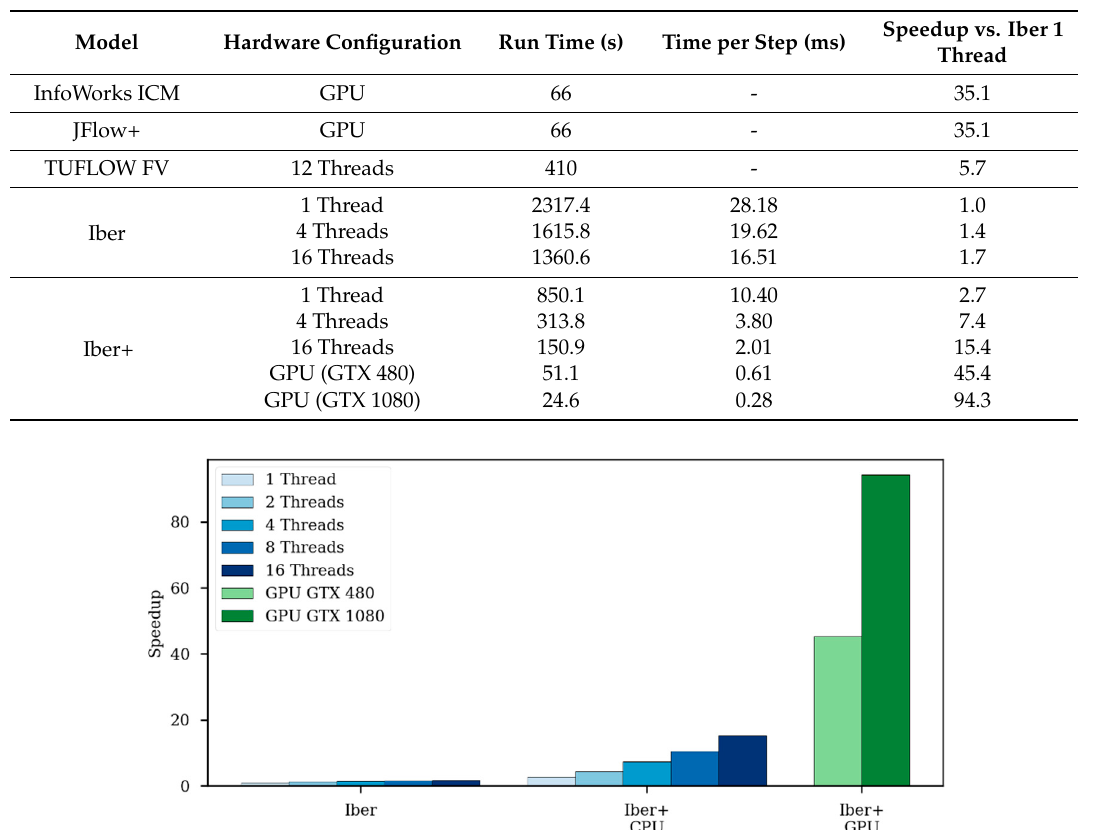
Table 5. Performance measurements for Test 8A. Total run time of the simulation in seconds, average processing time per time step in milliseconds and the achieved speedups compared with Iber running in a single thread.